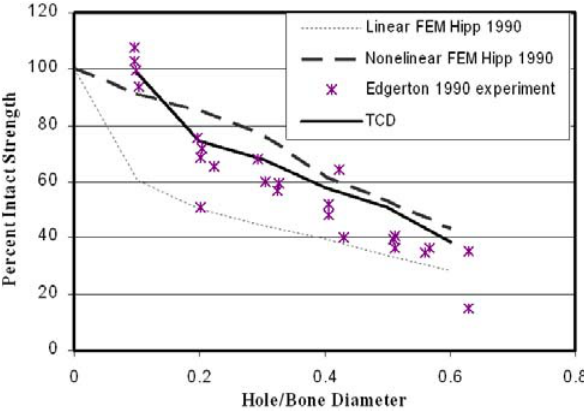
Figure 1: The effect of hole diameter (normalized by bone diameter) on fracture torque (normalized by fracture torque for bones containing no hole), for whole bones tested in torsion, containing single transcortical holes of various diameters. Predictions using the TCD and two other